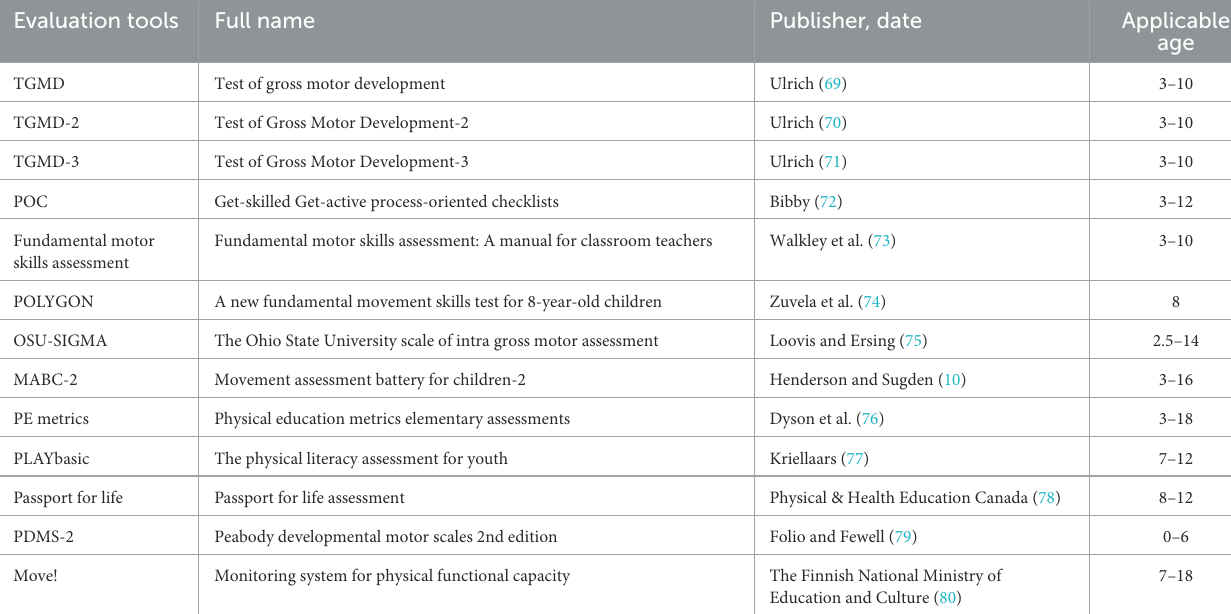
TABLE 2 List of fundamental movement skill evaluation